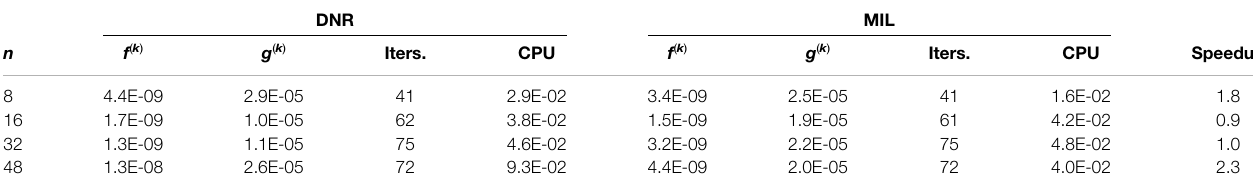
TABLE 2 | Performance comparison of DNR vs. MIL methods testing on Rosenbrock function.